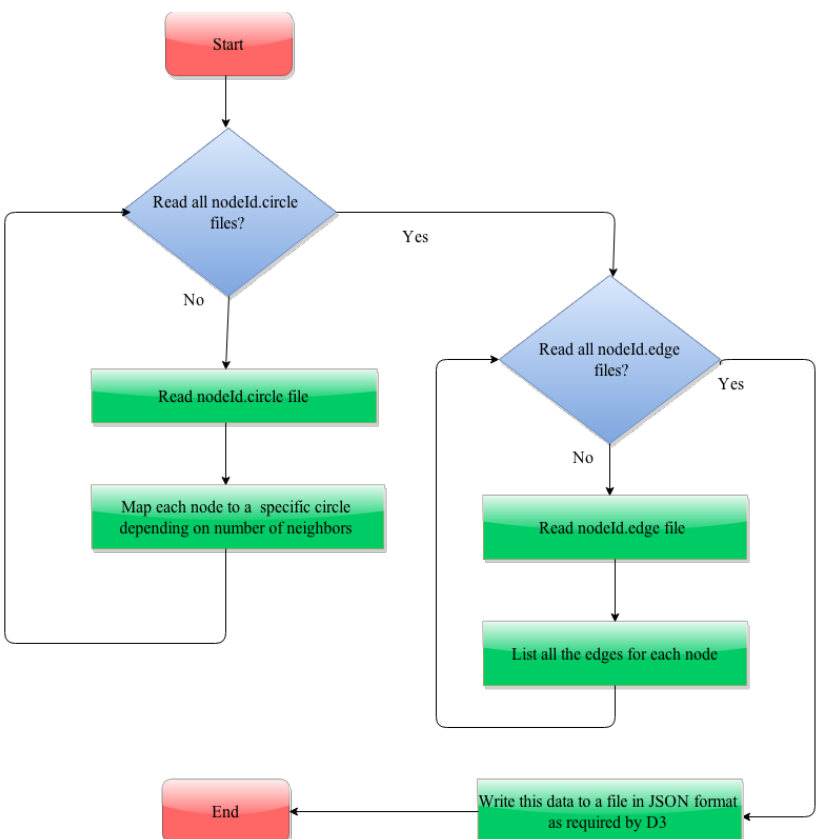
Figure 6. A flow chart to show the steps involved in the generation of the JSON file containing the interactions between